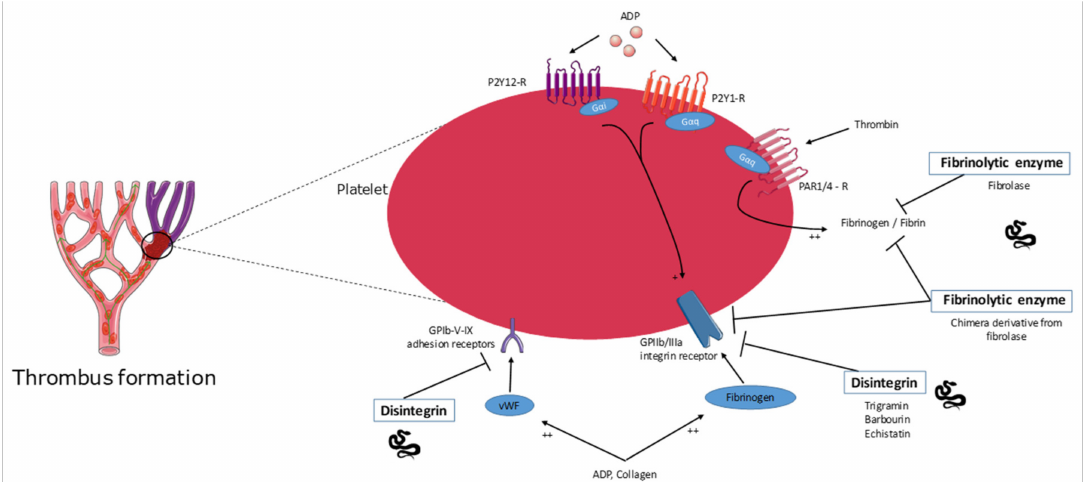
Figure 1. Overview of snake toxins acting on the vascular tone through activation/inhibition of receptors expressed at the surface of endothelial cells (EC) or vascular smooth muscle cells (VSMC). See text for details. PLA2: phospholipase A2; BPPs: bradykinin potentiating peptide; ANP/BNP-like peptide: atrial natriuretic peptide/brain natriuretic peptide; BNP: brain natriuretic peptide; 3FTXs: three-finger toxins; CRISPs: cysteine-rich secretory proteins; DNP: dendroaspis natriuretic peptide; MT- α : muscarinic toxin; H1-R: histamine H1 receptor; mAChR-M1: M1 muscarinic acetylcholine receptor; EDRF: endothelium derived relaxing factor; eNOS: endothelial nitric oxide synthase; NO: nitric oxide; GC: guanylate cyclase; Cav type L: L-type voltage-gated calcium channel.